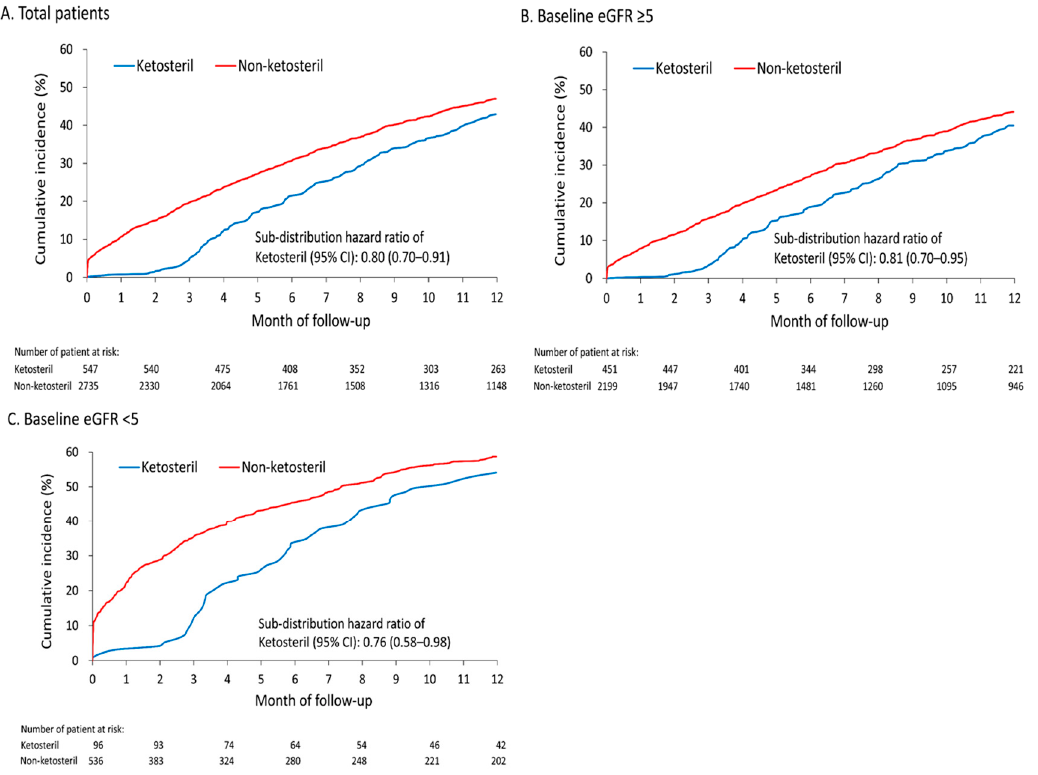
Figure 3. Cumulative incidence function of new-onset ESRD requiring the maintenance dialysis of patients in the Ketosteril and non-Ketosteril groups in the whole study population ( A ); patients with baseline eGFR > 5 mL / min / 1.73 m 2 ( B ); and patients with baseline eGFR < 5 mL / min / 1.73 m 2 ( C ).